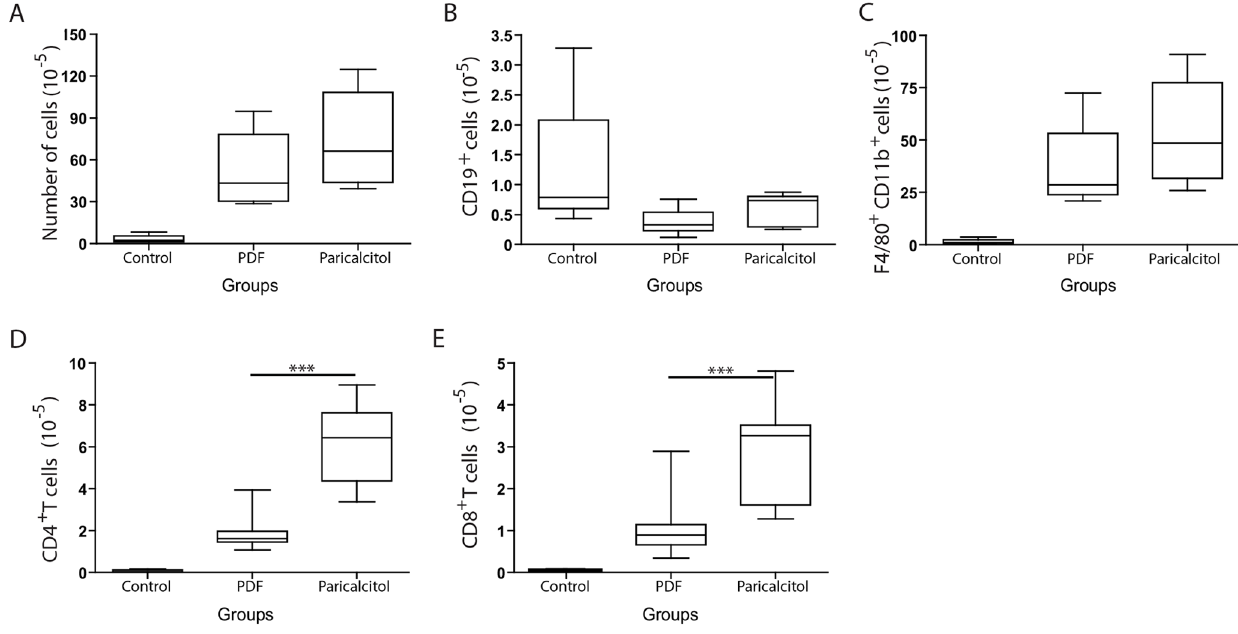
Figure 2. Paricalcitol changed the peritoneal T cell population in mice instilled with PDF. A) The paricalcitol group tends to increase the number of nucleated cells at the peritoneal cavity compared with the PDF group. B) The number of B cells was similar in the PDF and paricalcitol groups. C) There is no significant difference between the number of macrophages in the PDF and paricalcitol groups. D) Paricalcitol increased the numbers of CD4 + T cells compared with the PDF group. E) The treatment with paricalcitol increased CD8 + T cells in the peritoneal cavity. Statistical significance was determined using the Mann-Whitney test. *** P , .001; n $ 5 in each group.